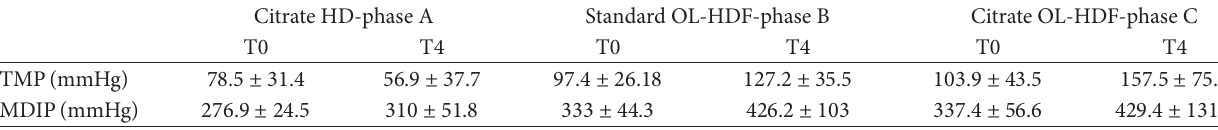
Table 2: Achieved operating dialysis monitor pressures.